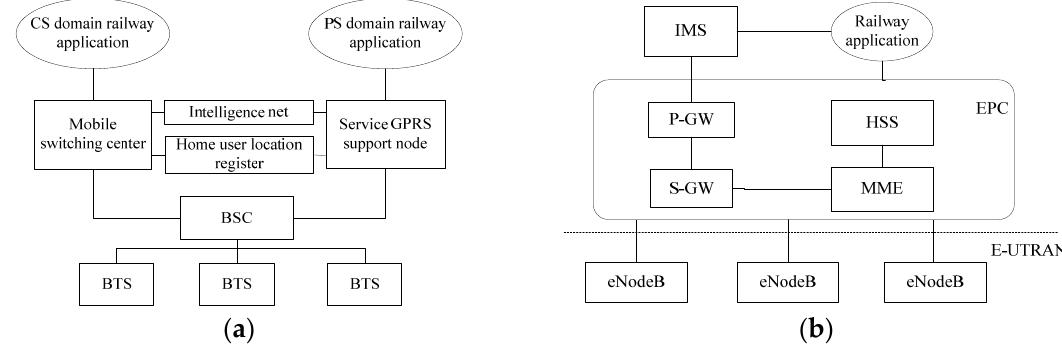
Figure 1. The network architecture of ( a ) GSM-R and ( b ) LTE-R. Compared with GSM-R, LTE-R is a typical broadband system, which has a signifi- cantly improved transmission rate, transmission delay, service firing, and performance.